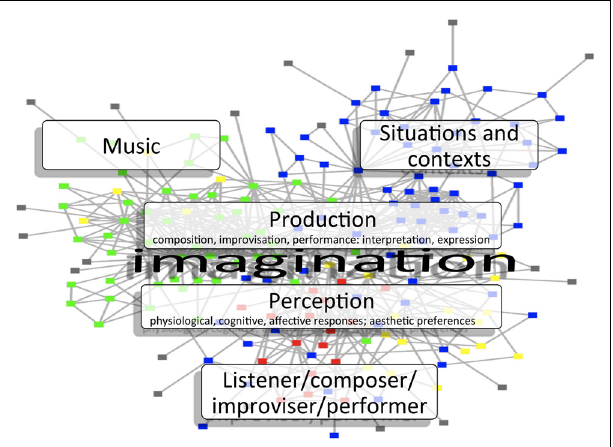
FIGURE 1 | Schematic representation of spreading activation through the components of the reciprocal-feedback model (RFM; based on Hargreaves, 2012). The arrows connecting the determinant boxes in previous versions of the RFM have been replaced here by networks of nodes, shown in schematic form in the background, and representing a cognitive level of explanation.The networks form mental representations of perceptions, actions, emotions, and thoughts, including those pertaining to the three determinants of musical experience: music, situations, and contexts, and Person (Listener/composer/improviser/performer). Activation of one part of the network spreads activation to other previously associated networks.The central role of imagination is represented schematically in the diagram in terms of musical experience (foreground), and of internal, mental representation